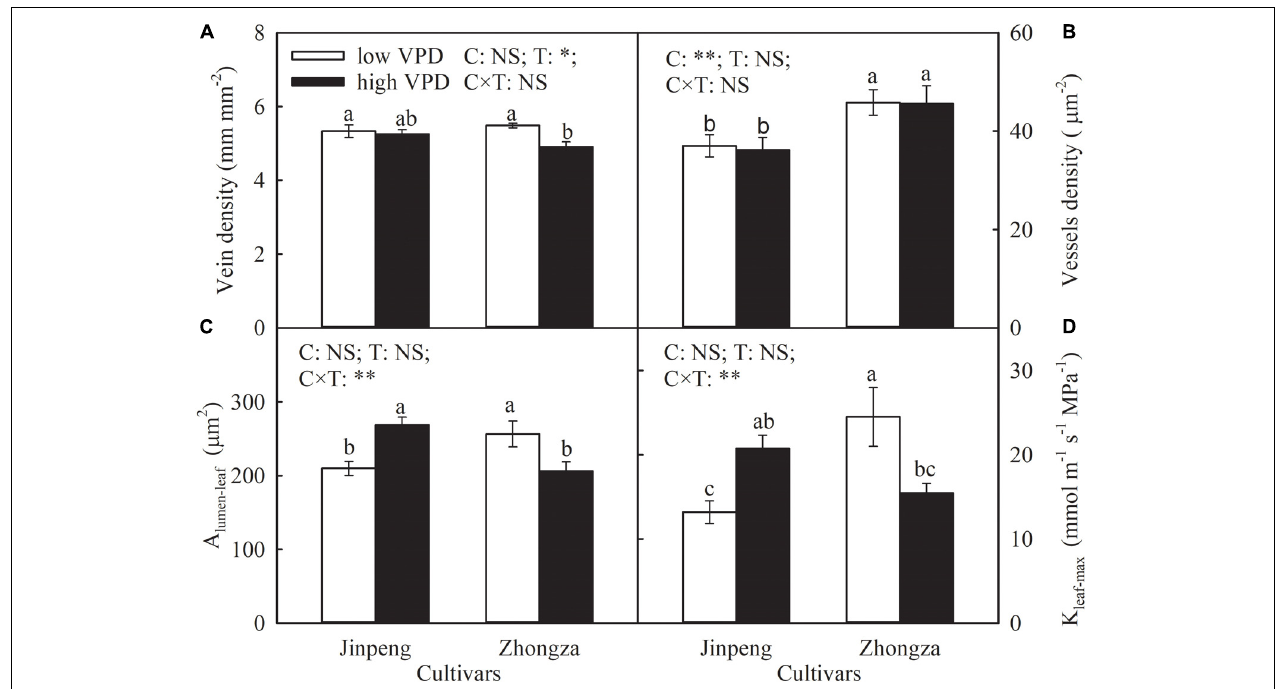
FIGURE 4 | Vein density (A) , vessel density (B) , lumen area of vessels in leaf vein (A lumen - leaf ) (C) , and maximum theoretical leaf vein axial hydraulic conductivity (K leaf - max ) (D) for two tomato cultivars, Jinpeng and Zhongza, grown under low (1.1–1.5 kPa) and high (2.2–2.6 kPa) VPD. Data are means ± standard error ( n = 5 plants). Different letters denote statistically significant differences (Duncan’s test, P < 0.05). Two-way ANOVA was used to estimate the effect of cultivar (C), treatment (T), and their interaction (C × T) ( ∗∗ P < 0.01; ∗ P < 0.05; NS, not